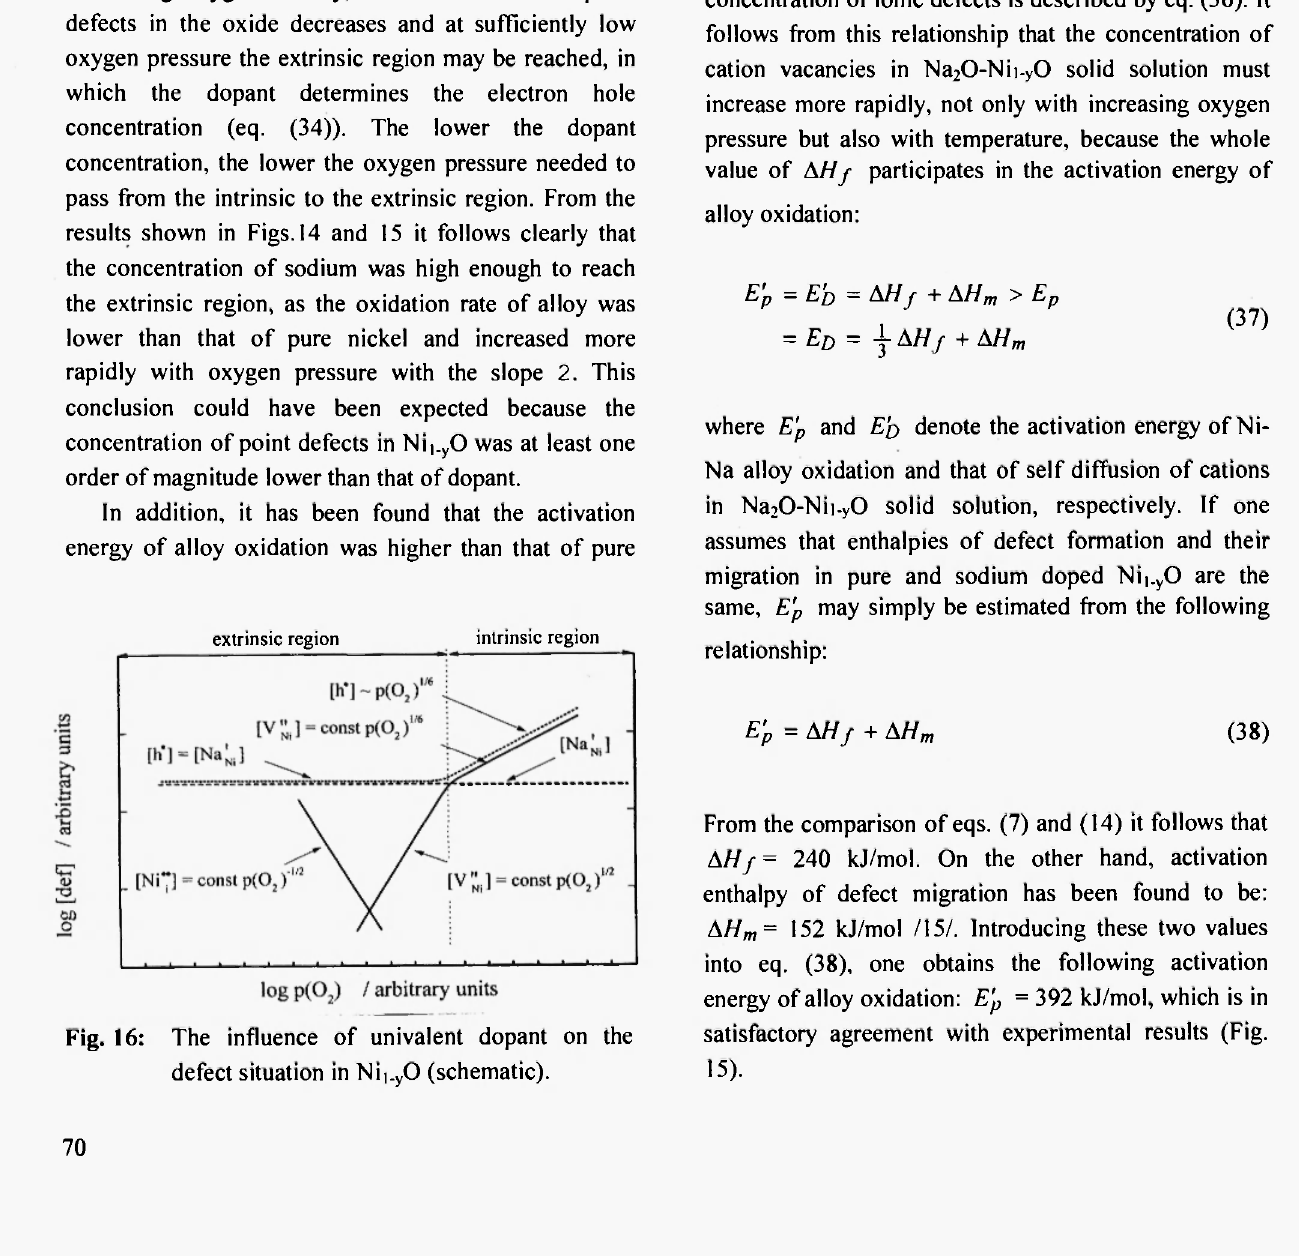
Fig. 16: The influence of univalent dopant on the defect situation in Ni,_ y O